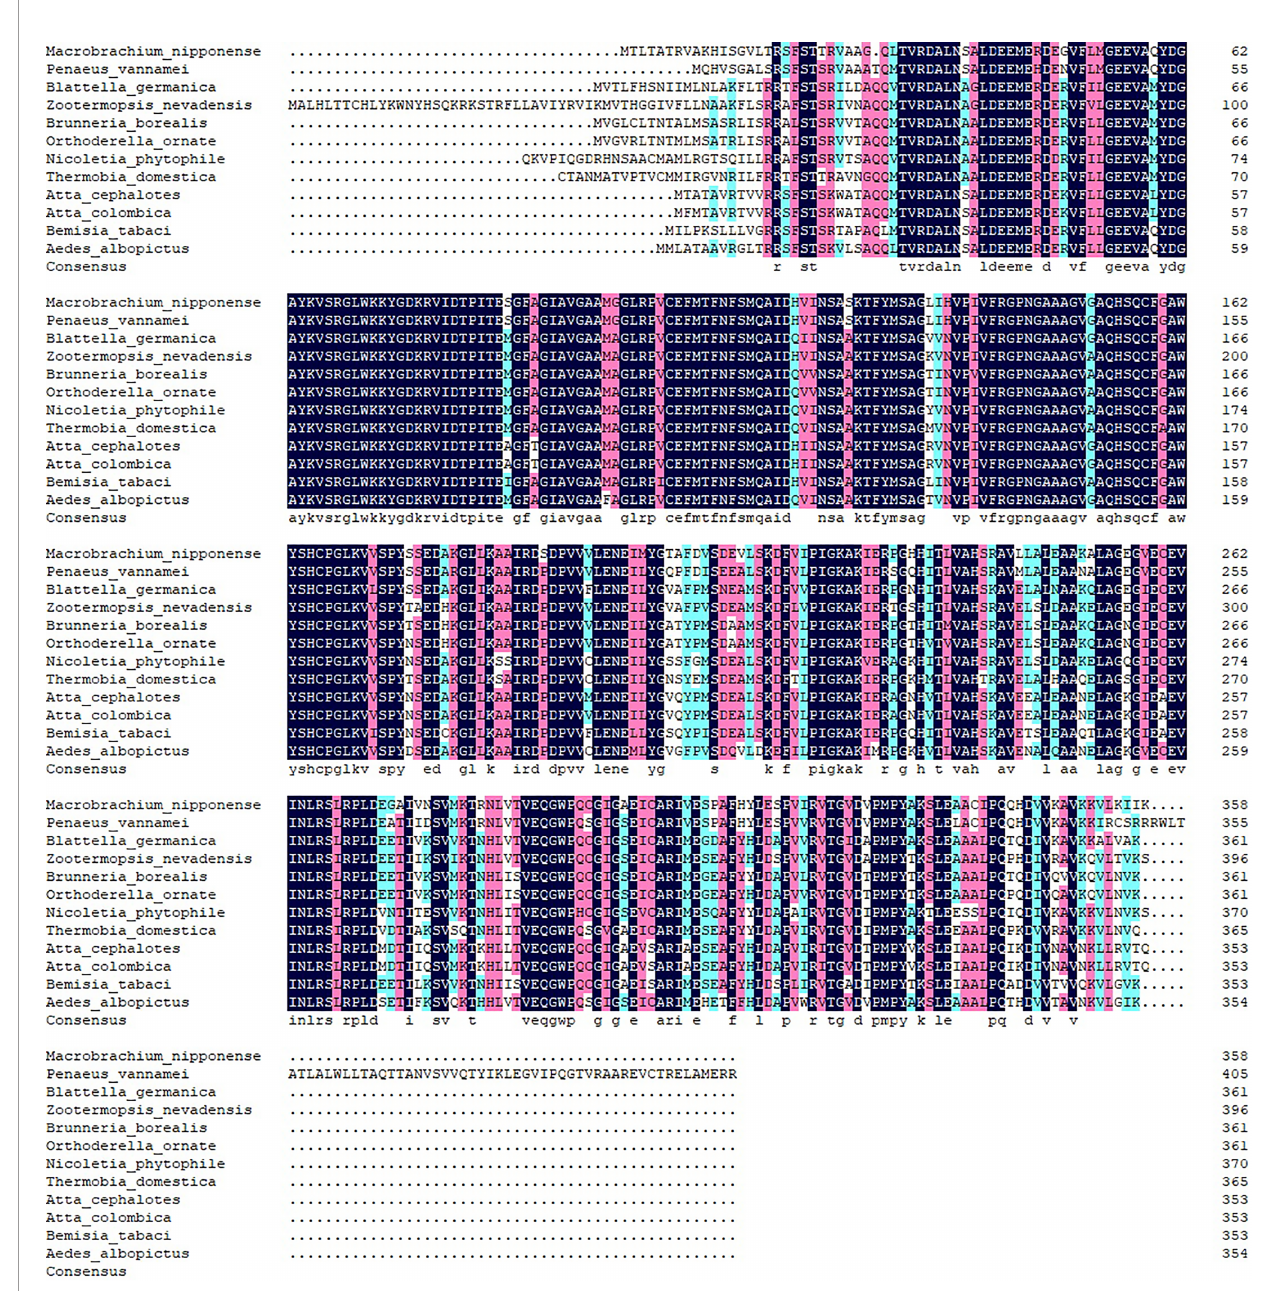
FIGURE 2 | The alignment of amino acid sequences of PDHE1 from different